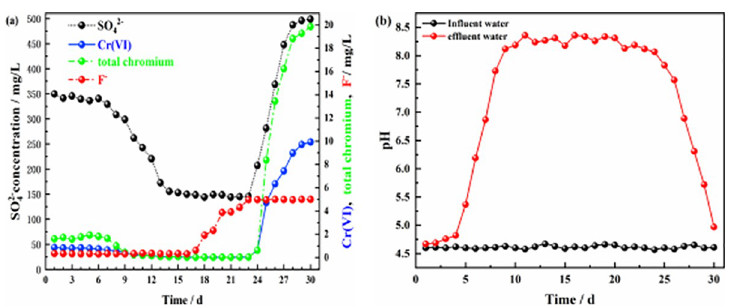
Fig 6. Effluent of dynamic column #1. (a) Effluent concentration of each pollutant ion; (b) pH values of influent and effluent water.